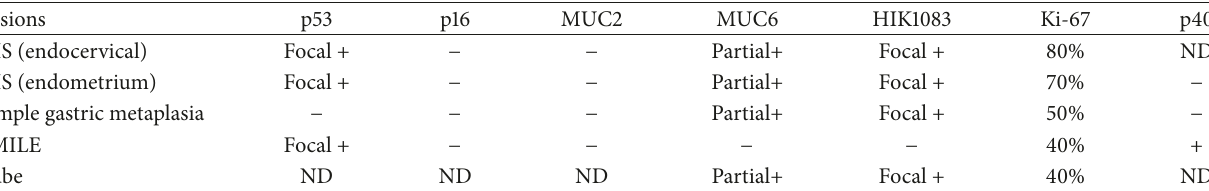
Figure 3: Endocervical tumor. (a) H-E stain. Fascicular and interlacing proliferation of spindle cells with hemorrhage. (b) H-E stain. Spindle cellshadhigh-gradeatypiaandactivemitosis.(c)H-Estain.Atypicalcellswereinfiltratingjustbeneaththemucosa.(d)Immunohistochemical stain of H-caldesmon. Tumor cells were diffuse positive. Table 2: Immunohistochemical analysis for each epithelial